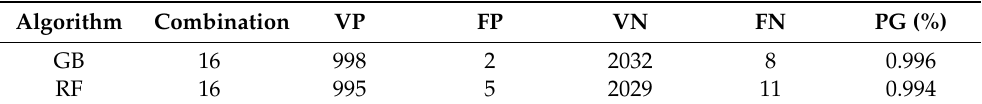
Table 10. Indicators of the performance of algorithms obtained from the confusion matrix for the rainy season.